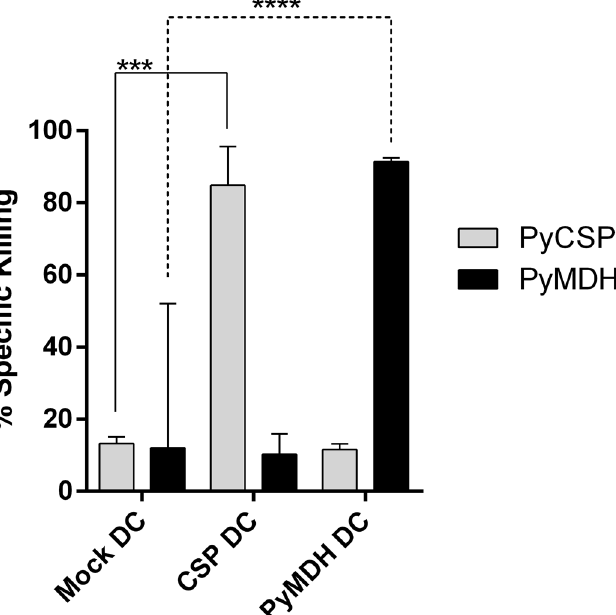
Five animals per group were vaccinated with either PyCSP or PyMDH using a DNA prime/ Lis- teria boost protocol. At a memory time point, all vaccinated mice plus five naïve infectivity